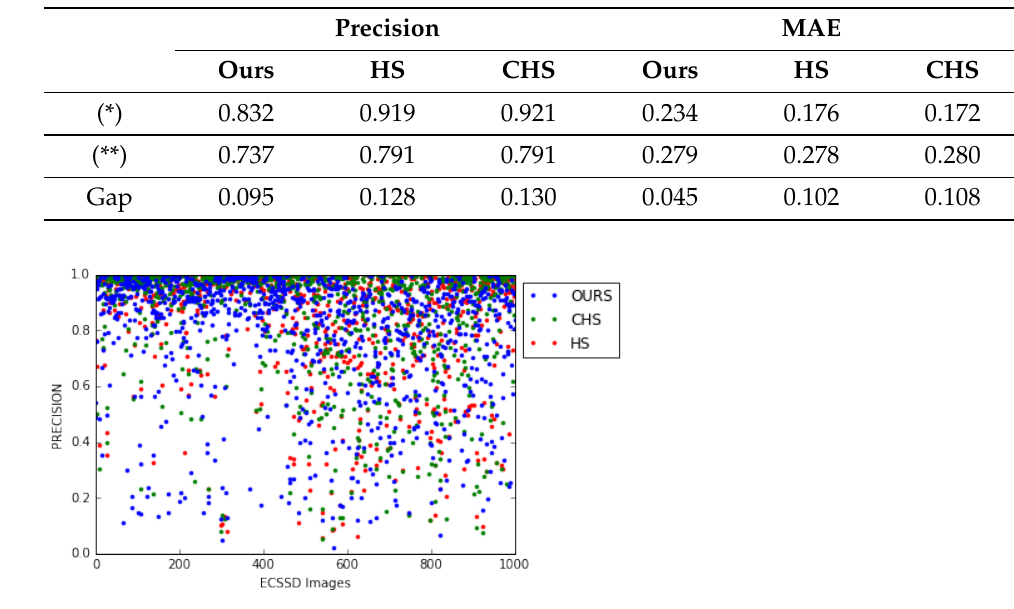
Figure 18. Comparison of the precision measure dispersion for our model and the HS [8], CHS [52] models on the ECSSD dataset.